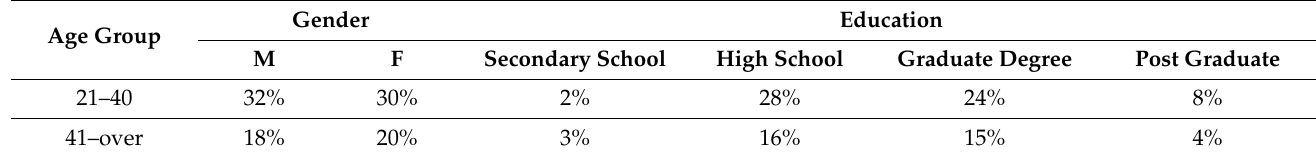
Table 2. Sample distribution on age and gender.